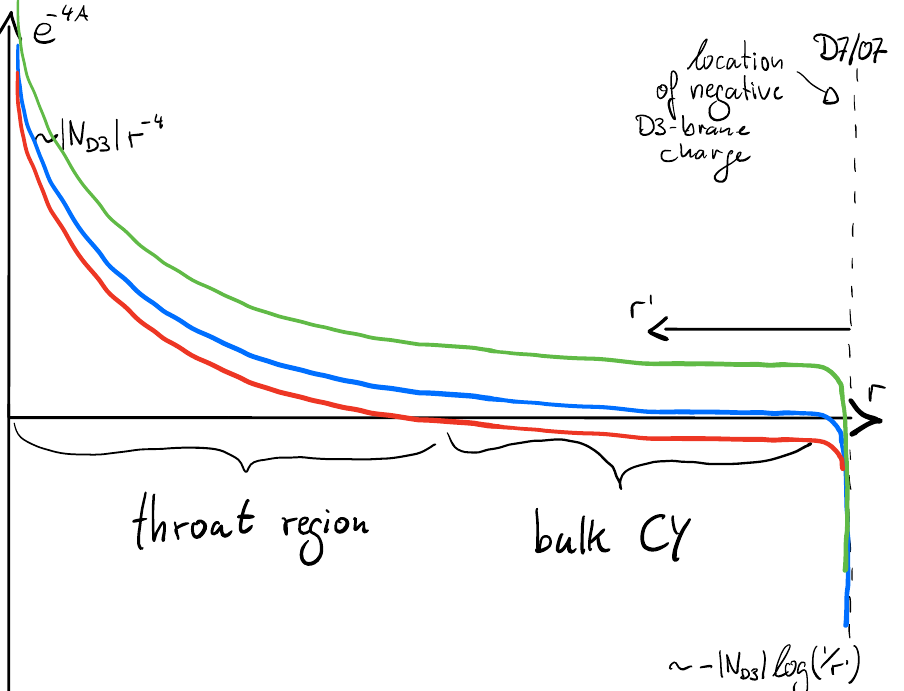
Figure 8 . We plot the schematic form of the inverse warp factor in a (cid:13)ux compacti(cid:12)cation for di(cid:11)erent values of the volume modulus. It diverges as j N D 3 j r (cid:0) 4 near the position of localized (or approximately localized) positive D 3 brane charge, and as (cid:0)j N D 3 j log(1 =r 0 ) near the locus of negative induced D 3 brane charge on D 7 =O 7 stacks. r is the transversal distance to the positive charge while r 0 is the transversal distance to the negative charge. The blue curve corresponds to taking t & N D 3 where the vanishing locus of e (cid:0) 4 A is marginally aligned with the D 7 =O 7 loci. The green curve corresponds to the case t (cid:29) N D 3 where the inverse warp factor vanishes only very close to the seven-brane stacks. The 10 d geometric picture is under parametric control. In the opposite regime t < N D 3 , shown in red, the singular locus reaches far into the